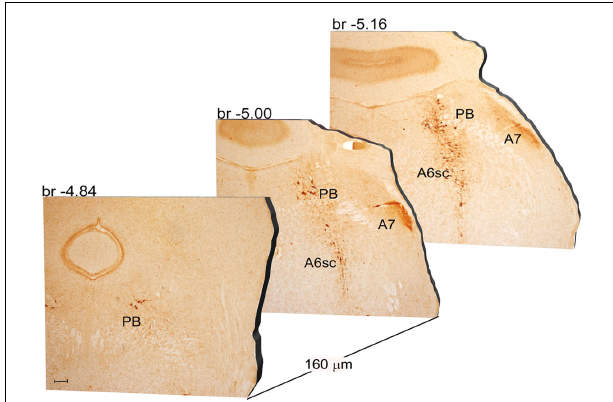
FIGURE 5 | Rostro-caudal reconstruction of the PB, A7 and A6sc catecholaminergic nuclei. TH immunostaining in 20 µ m coronal mouse brain sections regularly collected every 160 µ m from –4.84 to –5.16 Bregma levels. The figure shows a 3D-like antero-posterior reconstruction of the PB, A7 and A6sc catecholaminergic nuclei. Scale bar: 200 µ m.